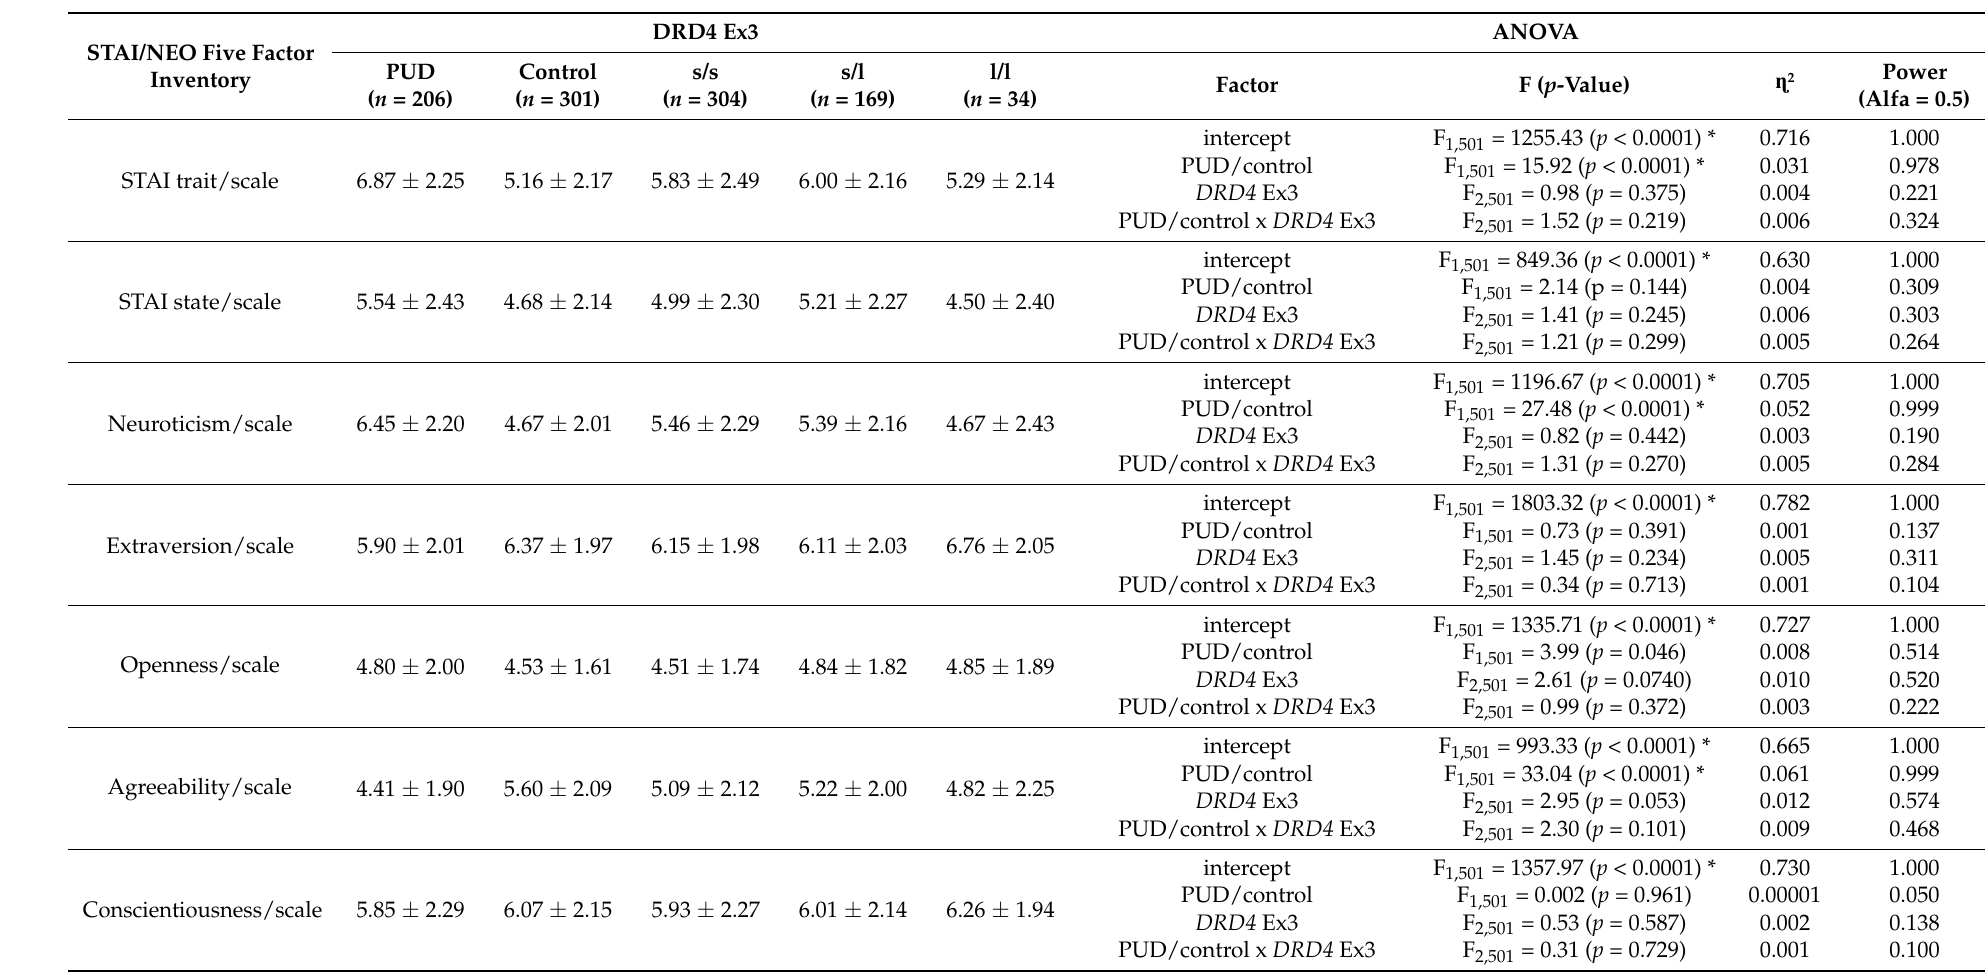
Table 6. Differences in DRD4 exon 3 ( DRD4 Ex3), the NEO Five Factor Inventory, the STAI scale between healthy controls and PUD subjects.